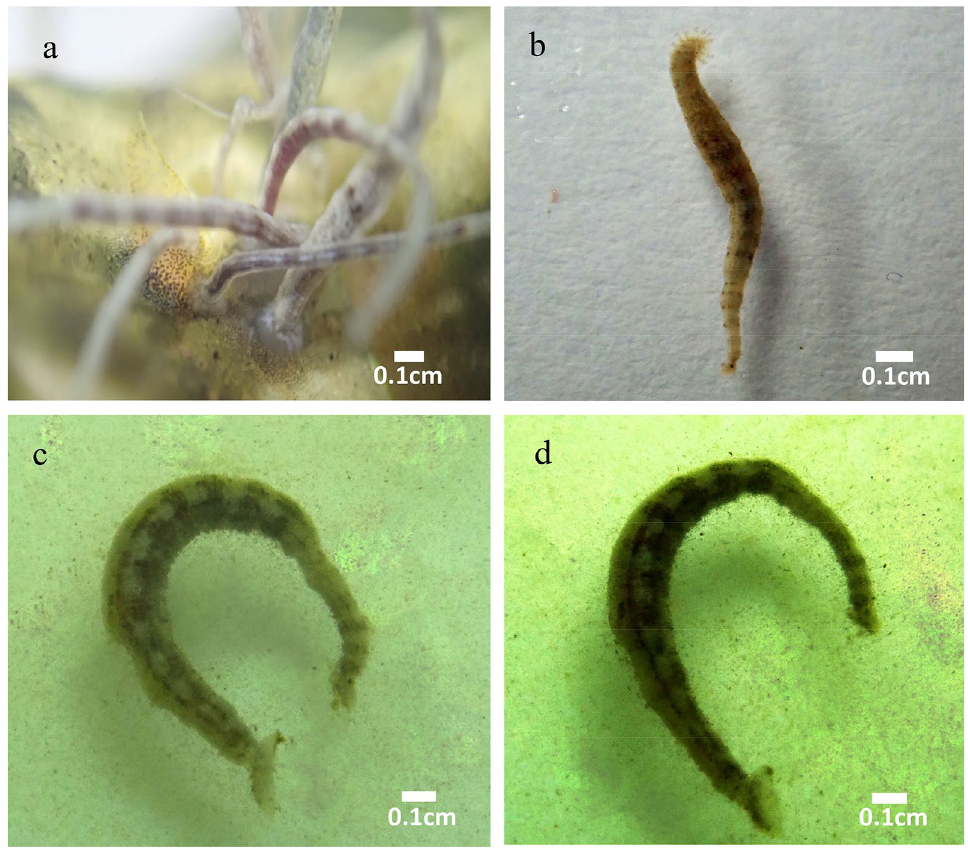
Figure 1. Zeylanicobdella arugamensis , ( a ) normal control, ( b ) formalin administered group, ( c ) and ( d ) Nephrolepis biserrata methanol extract administered